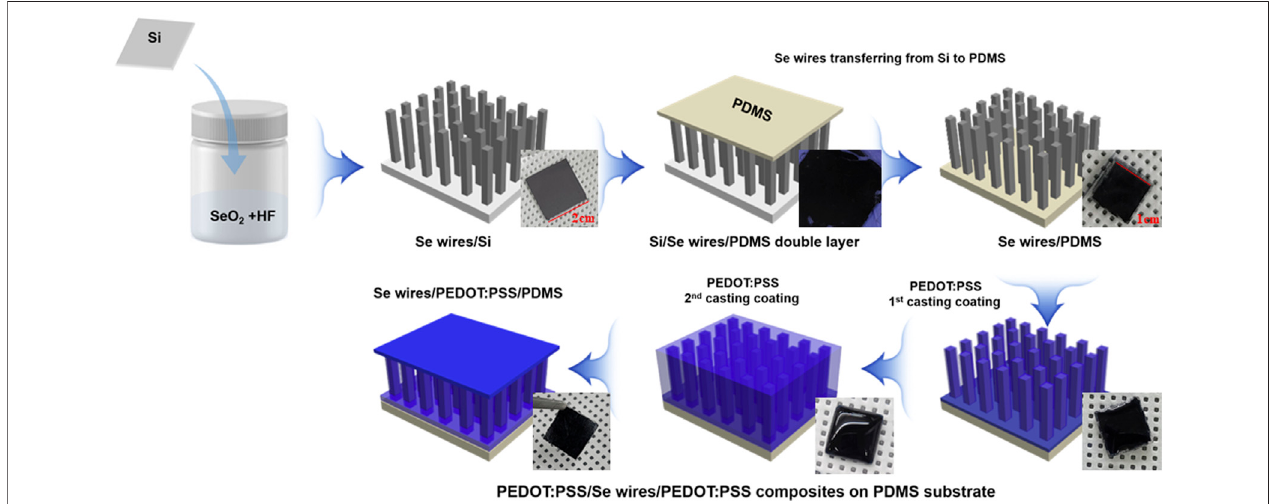
FIGURE 2 | Schematic representation of the synthesis of the Se nanowires by the galvanic displacement reaction of the Si wafer.